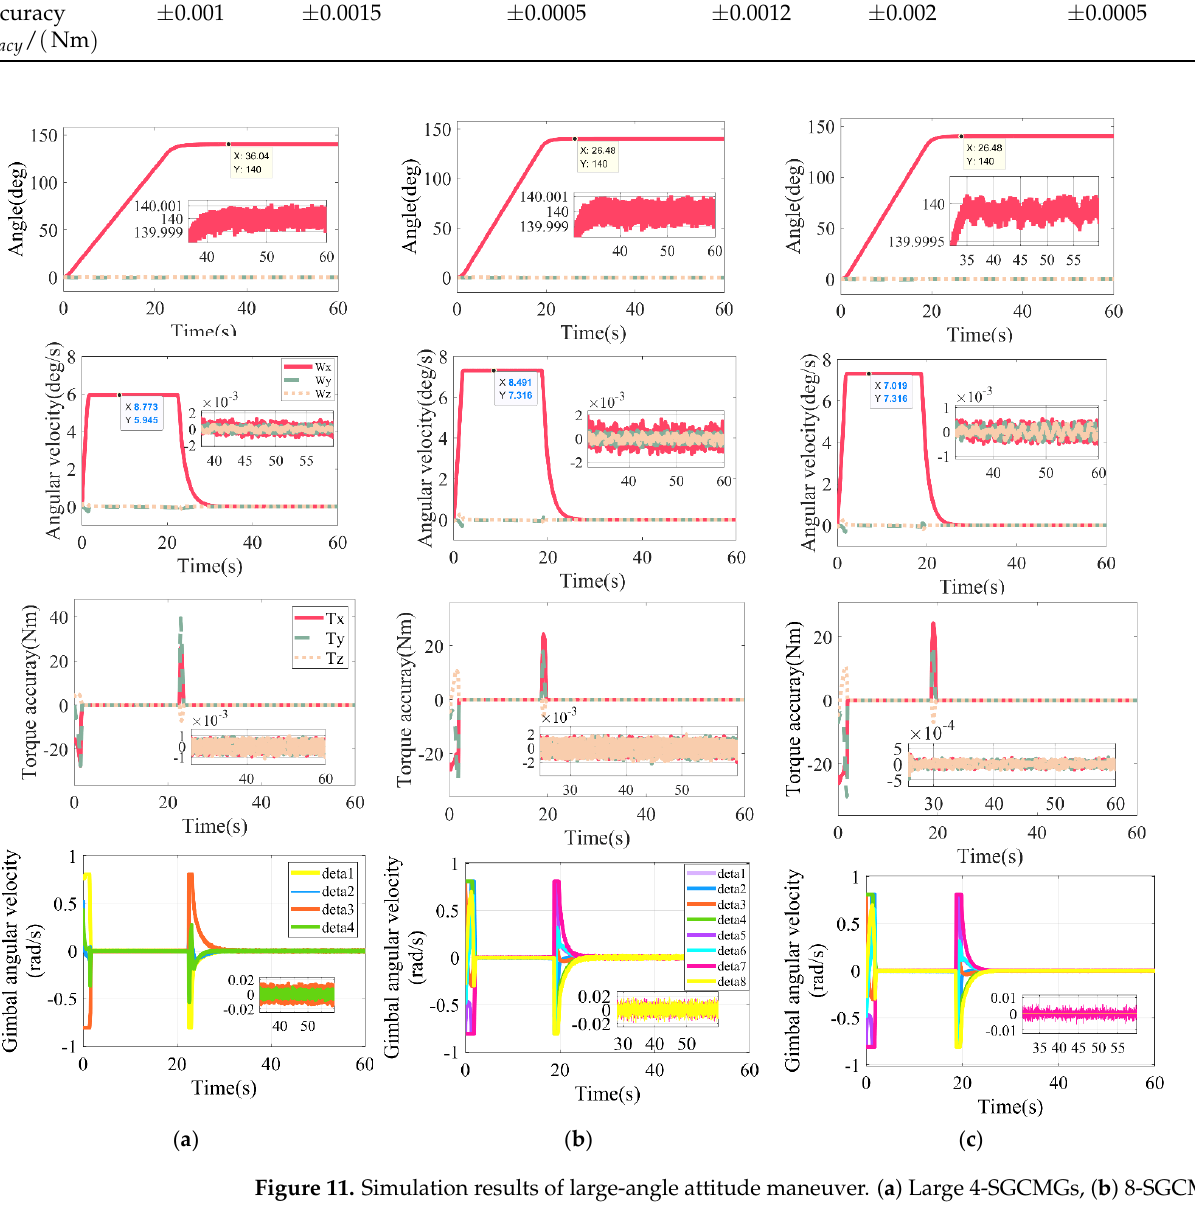
Figure 11. Simulation results of large-angle attitude maneuver. ( a ) Large 4-SGCMGs, ( b ) 8-SGCMGs, ( c ) Reconfiguration of 8-SGCMGs into